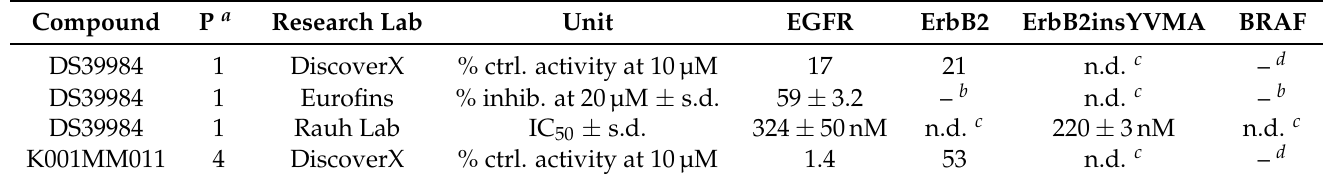
Table 3. Assay results for identified hit